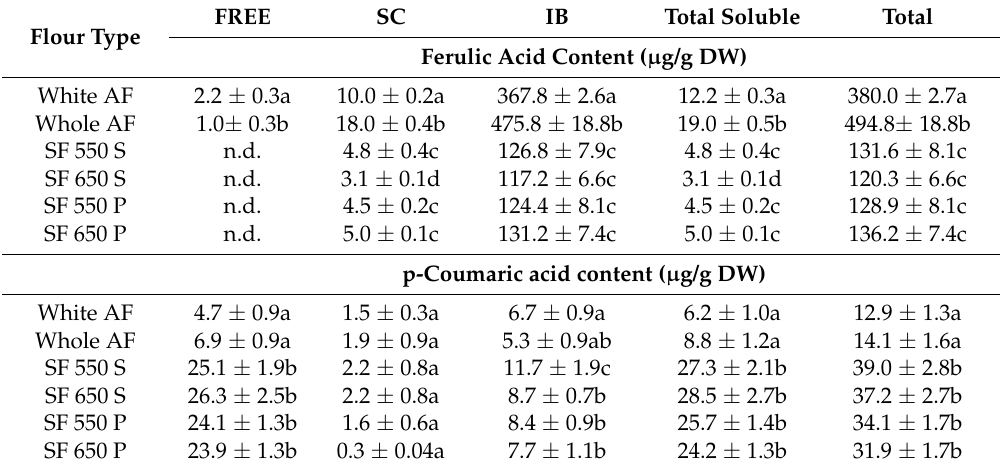
Table 2. Ferulic and p-coumaric acid content in their FREE, SC and IB fractions in AF and SF. samples. FREE SC IB Total Soluble Flour Type Ferulic Acid Content ( µ g/g